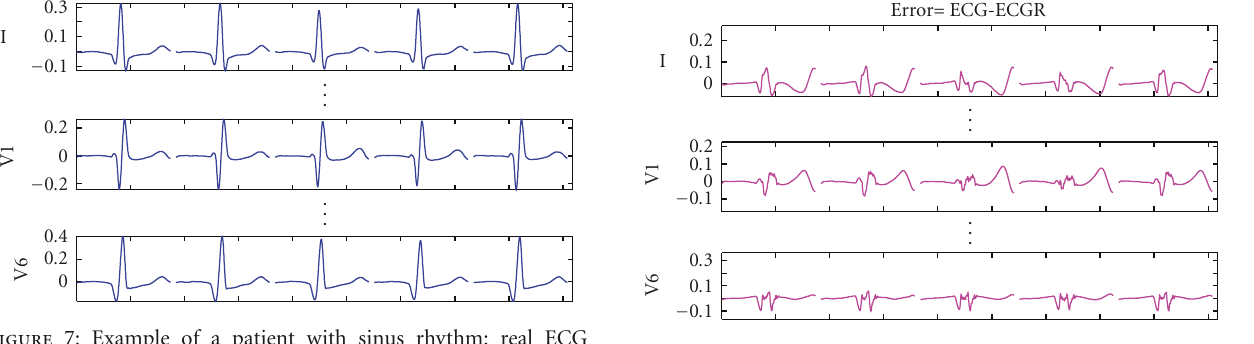
Figure 9: Example of a patient with sinus rhythm: reconstruction